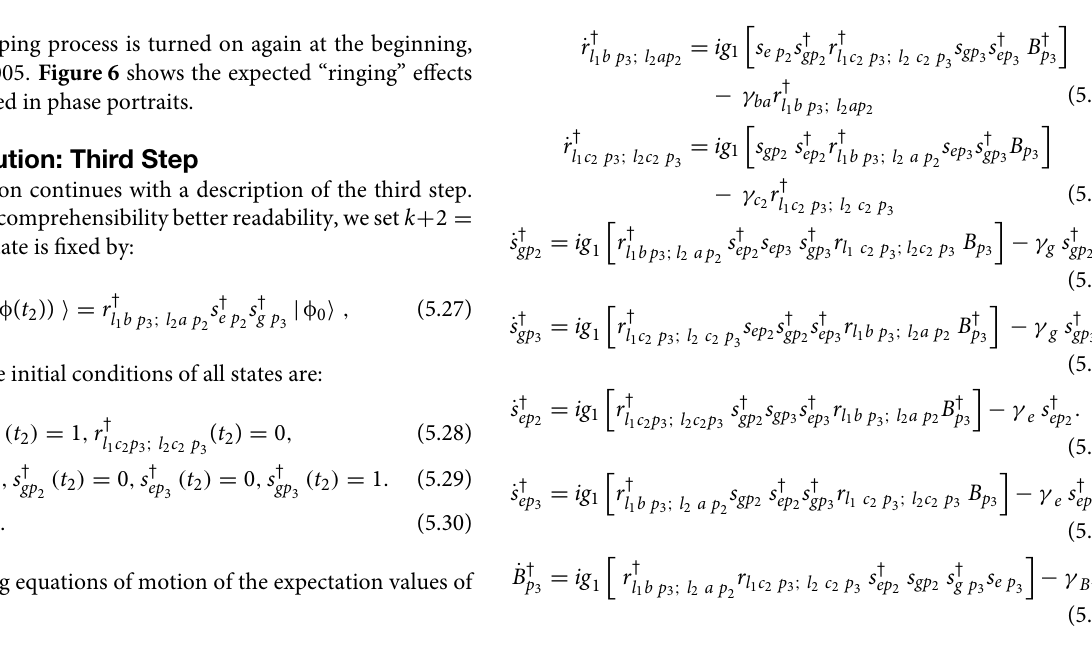
FIGURE 6 | Phase portraits of the real parts of the second step of the γ 0 .0005. All trajectories vary after their starting points (marked by a cross = following operators: bap 3 = r † l , c 1 p 2 = r † l , in the first figure) until they end up at the fixed point 0. The coupling 1 ap 3 ; l 2 bp 2 1 c 1 p 2 ; l 2 c 1 p 2 constants are g 1 g 2 0 . 1 , gp 3 = s † gp , Bp 2 = B † p . The value of the damping constant is gp 1 = s † gp 1 3 2 = =